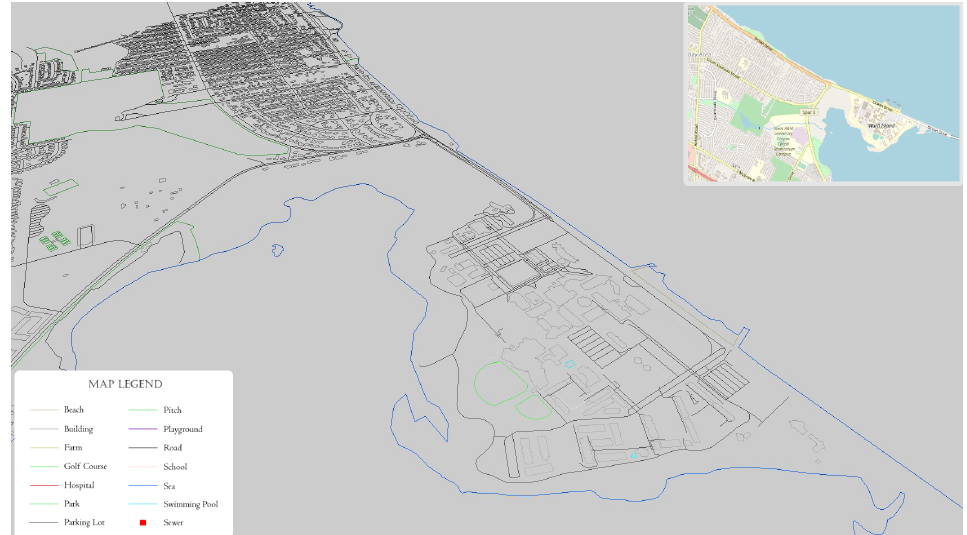
Figure 6. Visualization of Ward Island, home to Texas A&M University—Corpus Christi, and parts of Ocean